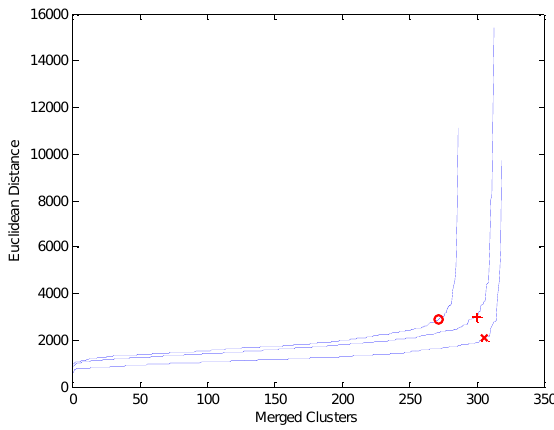
Figure 3. Three instances of “elbow” curves produced during HAC process using real hyperspectral data. Corresponding critical points c * in: “o” = (272, 2883) produced 16 clusters, “+” = (300, 2970) produced 14 clusters and “×” = (306, 2079) produced 14